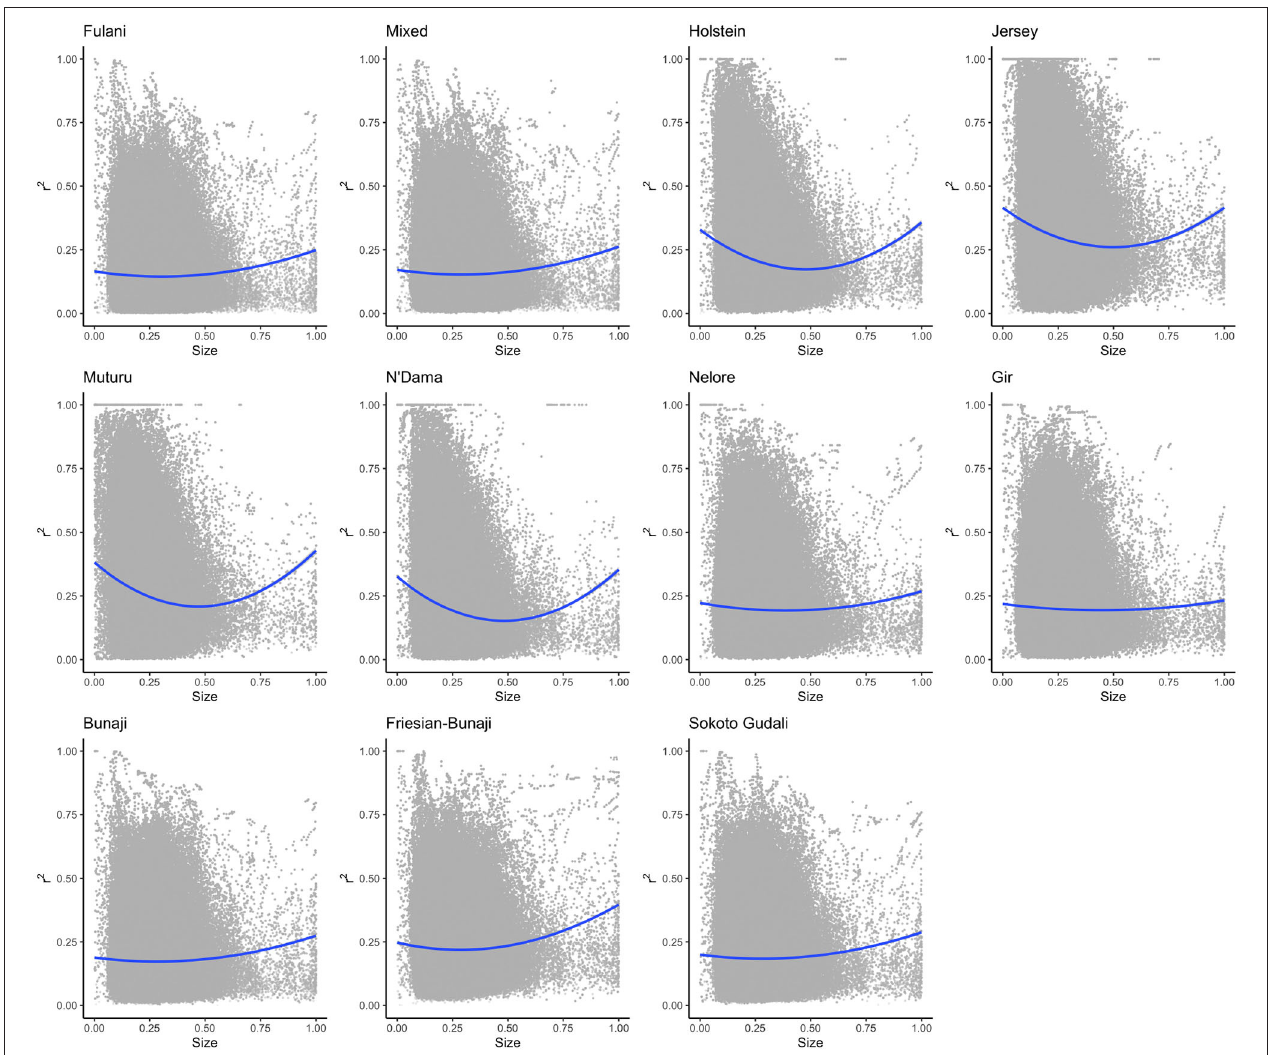
FIGURE 6 | The linkage disequilibrium, r 2 between pairs of SNPs in a 50 SNP window against the window’s size (length in base pairs). For visualization purposes the x-axis (50SNP window size) was center scaled between 0 and 1. A second degree polynomial fitted to show the trend in r 2 for each breed. The window size, representing the captured haplotype lengths and their average r 2 (averaged across the SNPs within the window) shows the ascertainment bias of the array and its spacing design against the non-taurine breeds. Patterns of loss in LD and the range of LD differs between lineages based on the window size (affected by both genotypes and spacing of the them within the